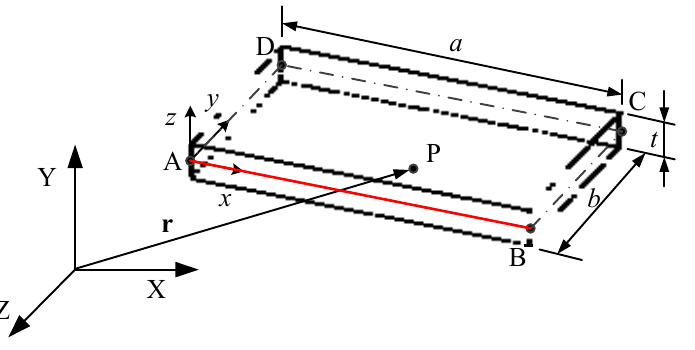
Figure 2. Single plate element.